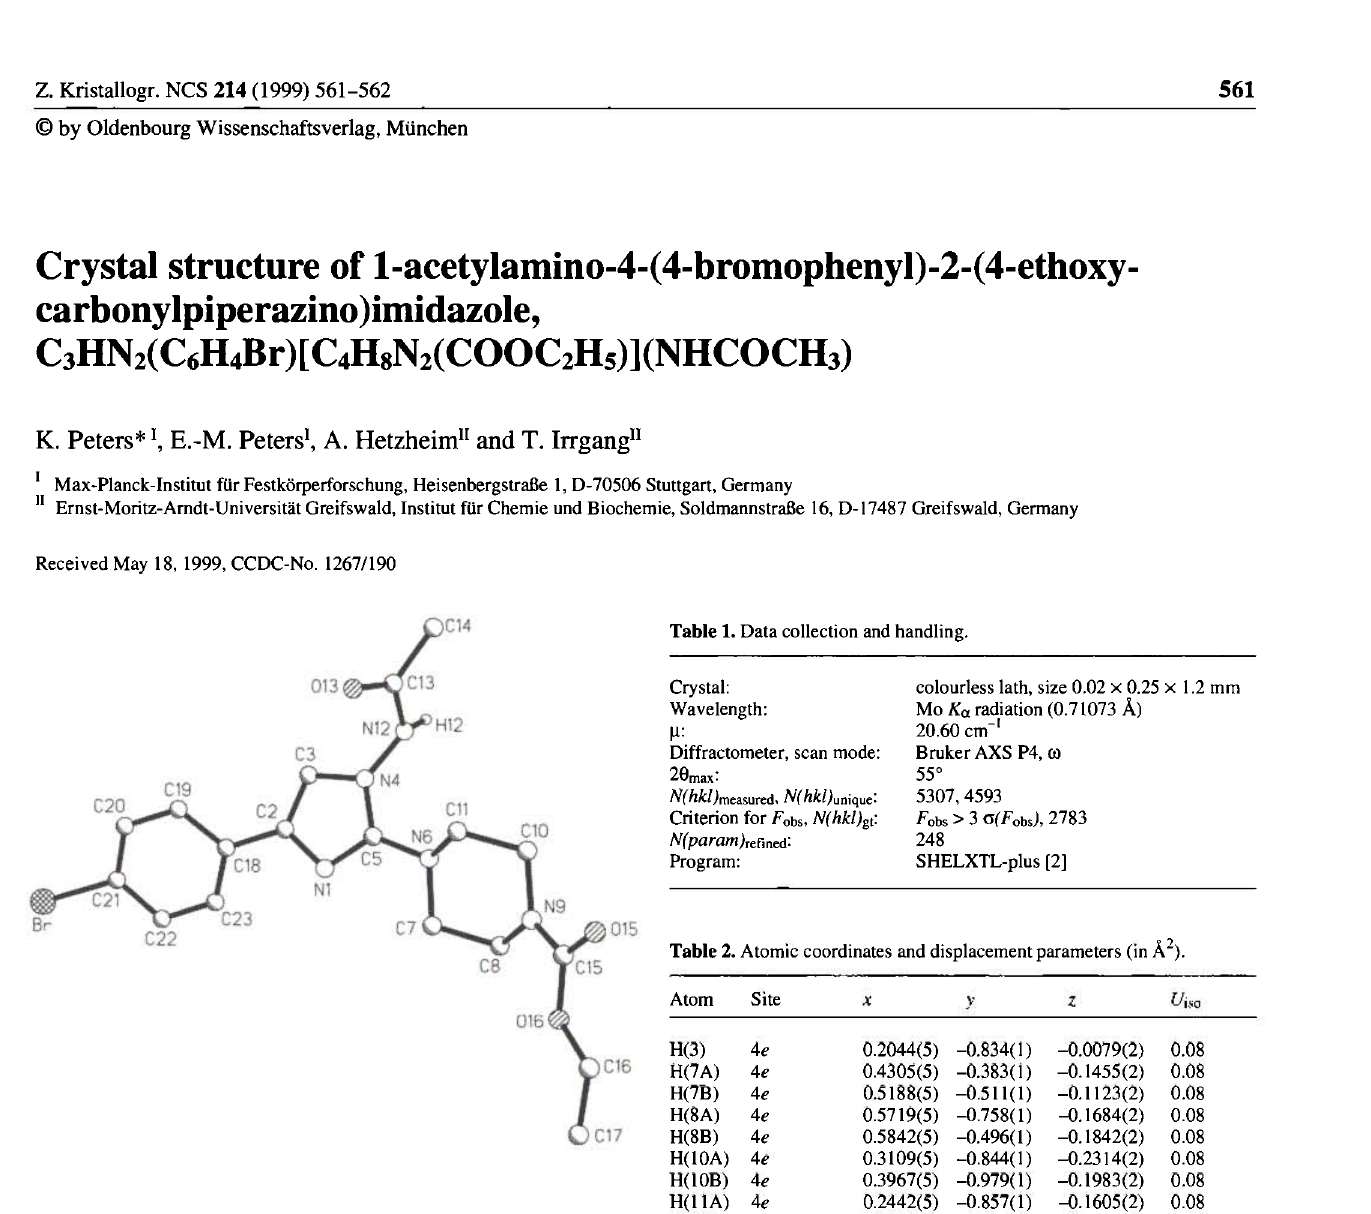
Table 2. Atomic coordinates and displacement parameters (in A 2